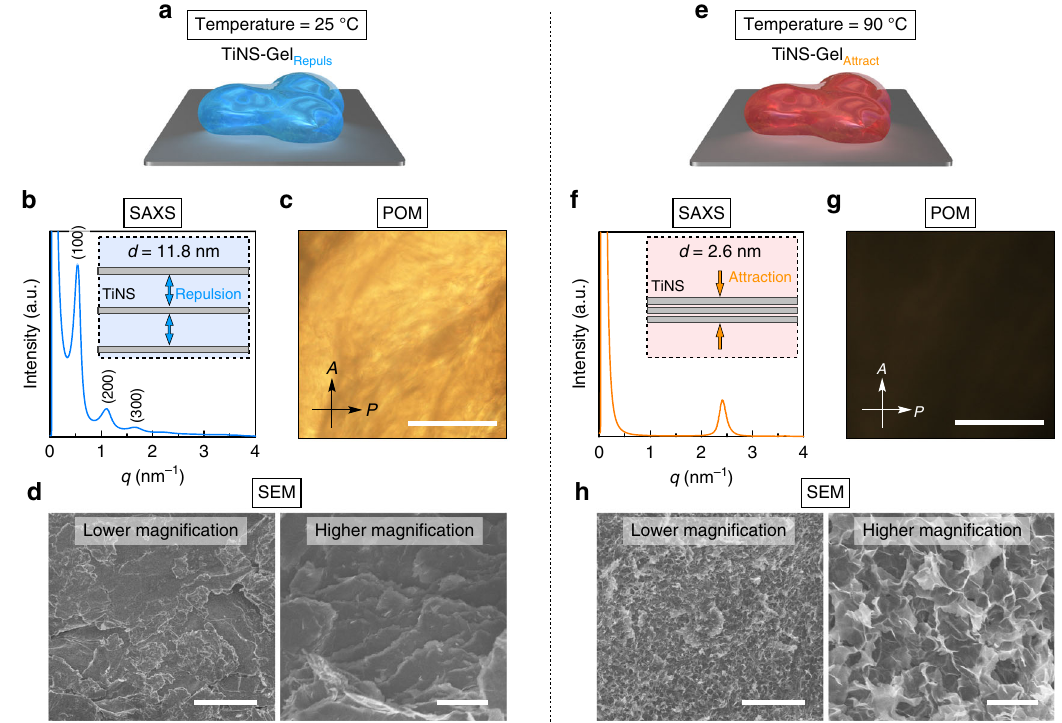
Fig. 2 Internal structures of TiNS-Gel Repuls and TiNS-Gel Attract . a , e Schematic illustrations of the hydrogel of TiNS (TiNS-Gel) in a repulsion-dominant state (TiNS-Gel Repuls ; a ) and an attraction-dominant state (TiNS-Gel Attract ; e ). b , f Small-angle X-ray scattering (SAXS) pro fi les of TiNS-Gel ([TiNS] = 14 wt %) at 25 °C ( b ) and 90 °C ( f ). Insets indicate a schematic illustration of the nanosheet arrangements at a nanoscale level. c , g Polarized optical microscopy (POM) images under crossed Nicols of TiNS-Gel ([TiNS] = 14 wt%) at 25 °C ( c ) and 90 °C ( g ). d , h Scanning electron microscopy (SEM) images of freeze-dried samples of TiNS-Gel ([TiNS] = 14 wt%) prepared by rapid freezing from 25 °C ( d ) and 90 °C ( h ) using liquid nitrogen. Scale bars: 1 mm ( c , g ); 50 µ m ( d , h , left); 10 µ m ( d , h ,